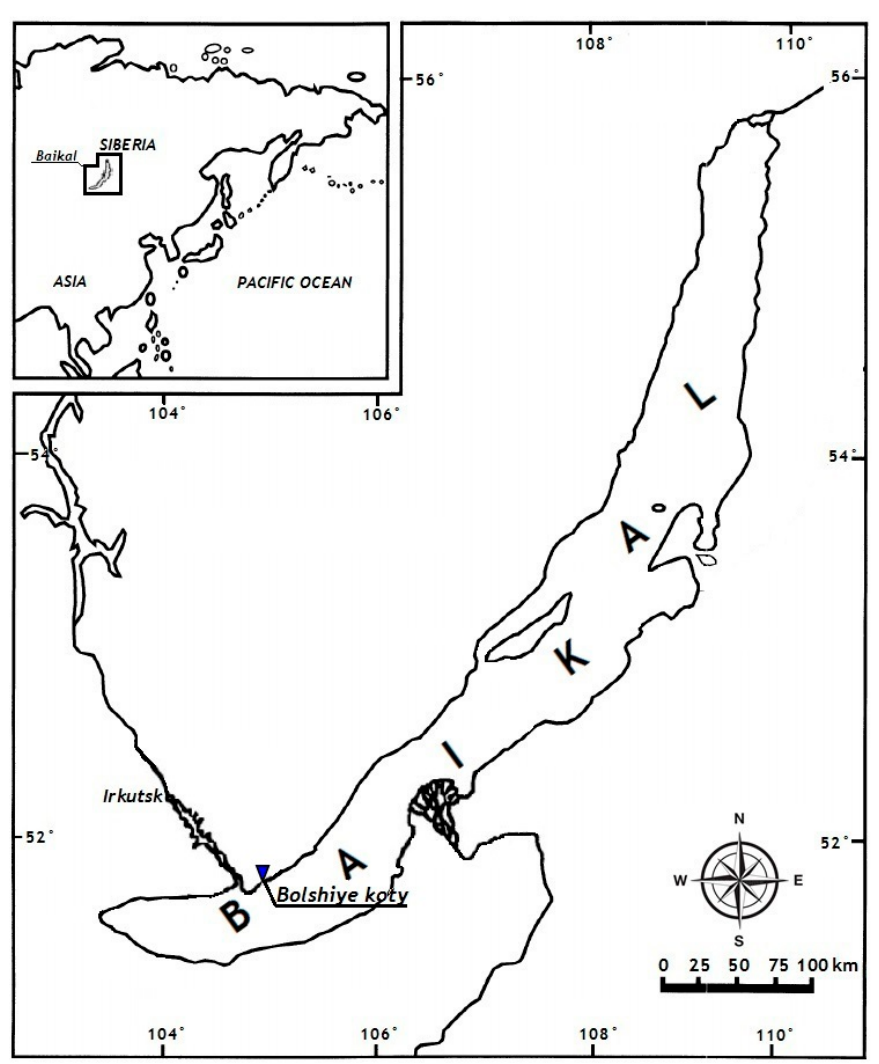
Figure 1. Map of sampling station at Lake Baikal. Additionally, from June to October 2020, samples were taken every 3 days from the surface of the lake at 50–60 m from the shore at a distance of 1.5 km west of the